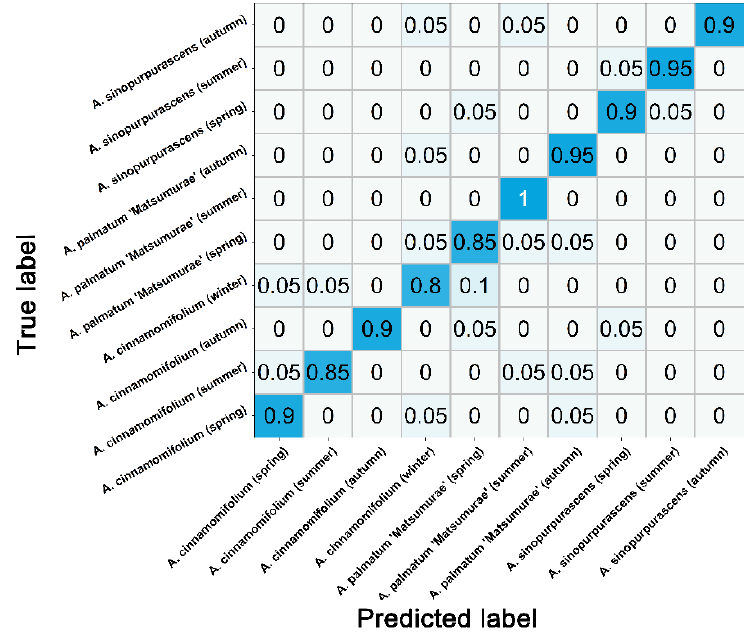
Figure 7. Confusion matrix of proposed flow chart.